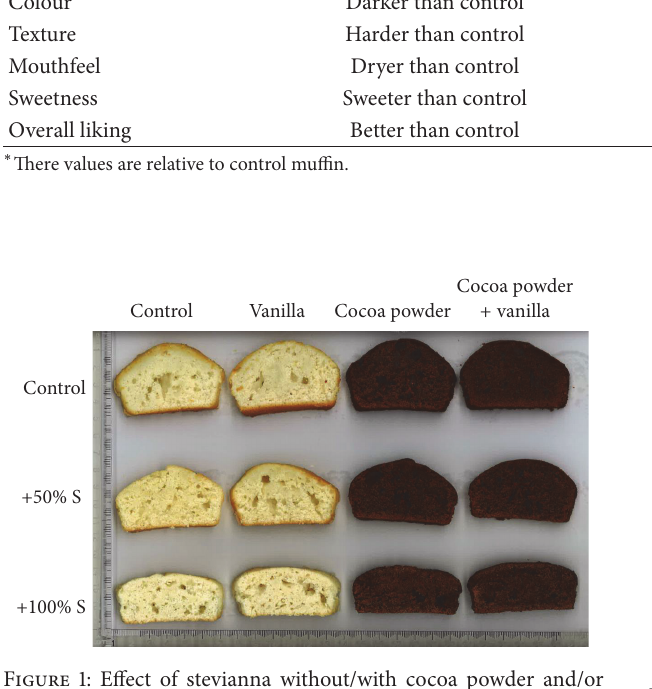
Figure 3: Effect of stevianna without/with cocoa powder and/or vanilla on the crumb colour of muffin. Control (C); vanilla (V); cocoa powder (CP); cocoa + vanilla (CP + V); 50% stevianna (50S); 50% stevianna + vanilla (50S + V); 50% stevianna + cocoa (50S + CP);50%stevianna+cocoa+vanilla(50S+CP+V);100%stevianna (100S); 100% stevianna + vanilla (100S + V); 100% stevianna + cocoa (100S + CP); 100% stevianna + cocoa + vanilla (100S + CP +